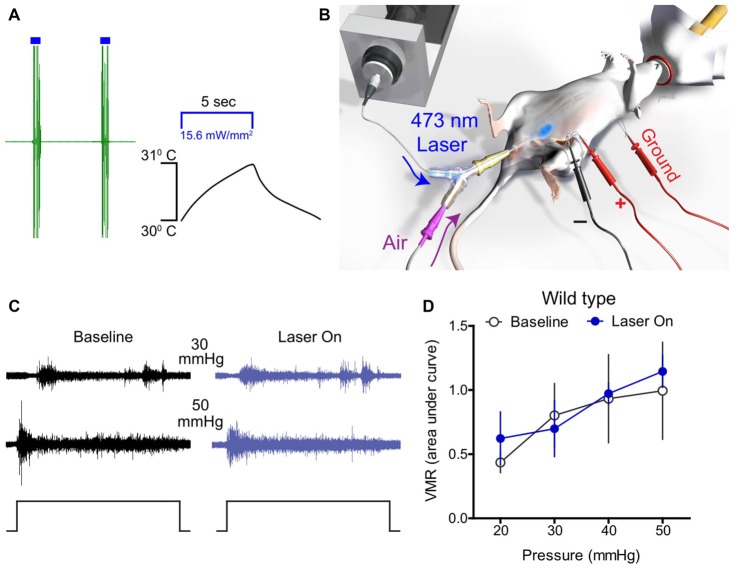
Optical stimulation of bladder afferents did not change bladder distension-evoked responses in wild type mice. (A) A representative trace shows that optical stimulation of glabrous skin elicited a robust hind paw withdrawal-evoked abdominal electromyograph (EMG) response in ChR2-expressing mice. Thermistor measurements of skin temperature at the site of stimulation skin show that temperature did not increase more than 1°C upon laser illumination, suggesting that increased EMG activity was not a heat-evoked response. (B) Schematic depicting bladder distension, visceromotor reflex (VMR) recording, and optical stimulation setup. (C) Representative raw EMG traces from wild type mice during 30 and 50 mmHg bladder distension before (baseline) and during (laser on) blue light stimulation. (D) Transurethral fiber optic delivery of blue light to the bladder lumen (laser on) did not affect the evoked response to bladder distension compared with baseline (pre-laser) responses in wild type mice (P > 0.05, two-way ANOVA; n = 8 mice).